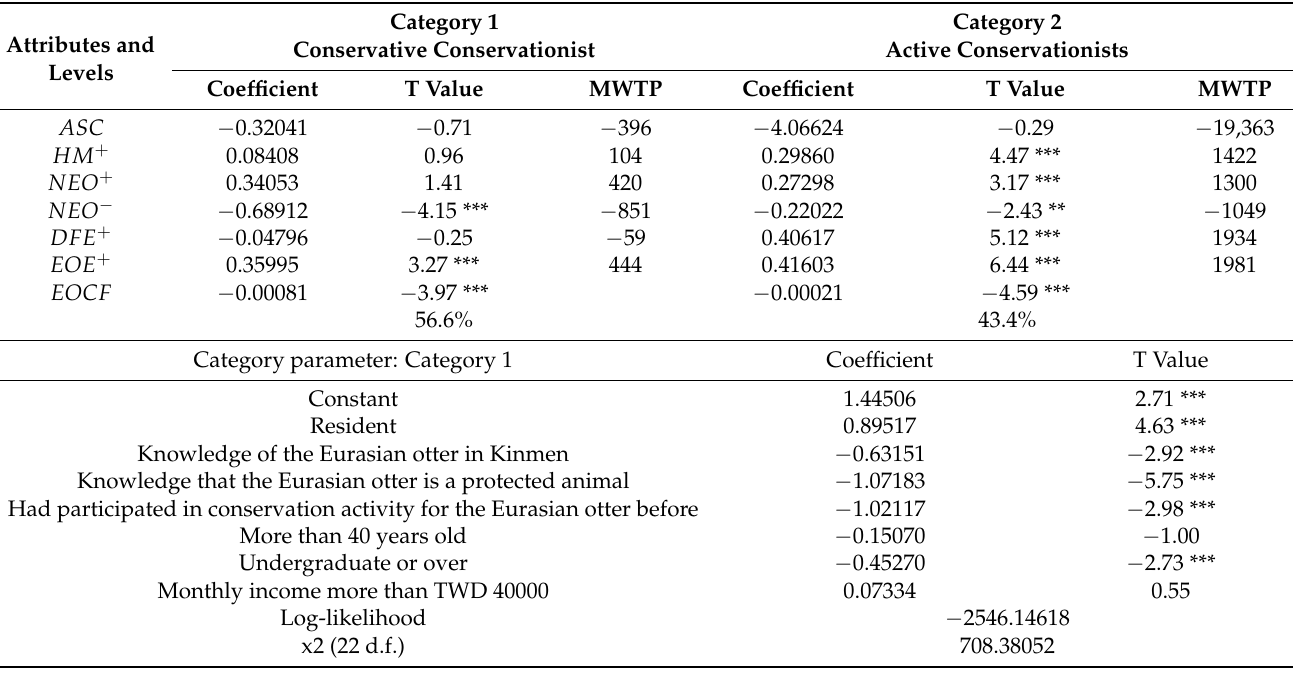
Table 4. Market segmentation of Eurasian otter conservation for the two